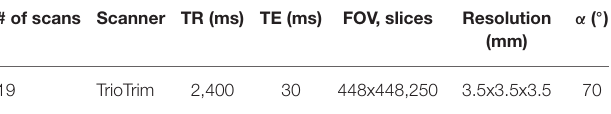
TABLE 4 | MRI scan parameters for fMRI scans.